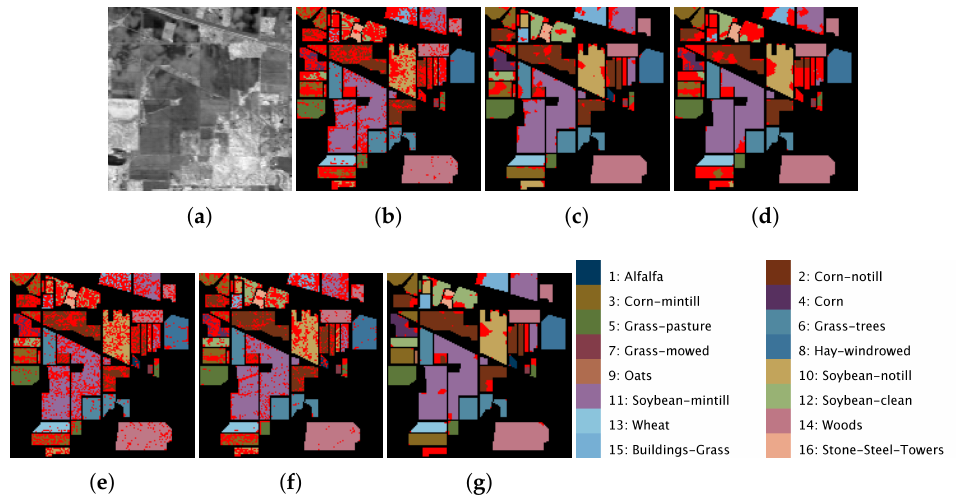
Figure 13. 2D angular transformation of the original hyperspectral image ( a ) and the results of the application of MLR ( b ); ppMLR ( c ); MLRpr ( d ); CRNN ( e ); SVM ( f ); and ECAS-II-SVM ( g ) classification methods to the Indiana scene. Misclassified pixels are marked with red dots. The classification methods have been trained using 3% of the samples of each